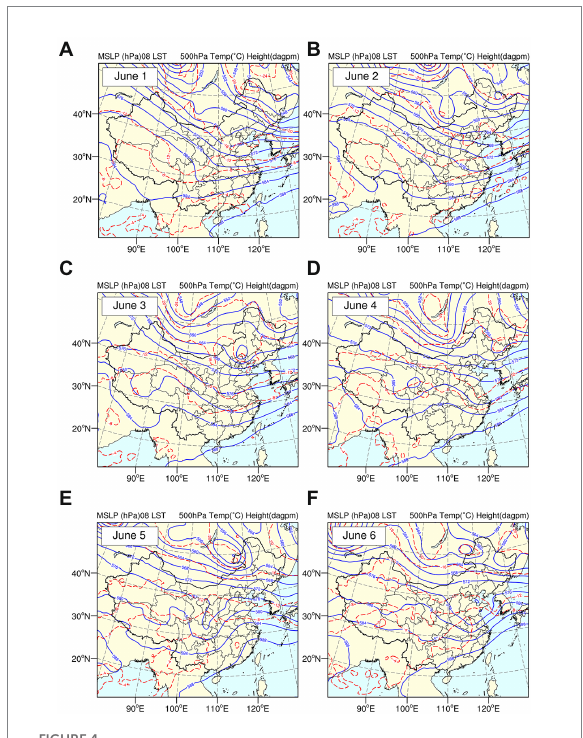
FIGURE 4 (A-F) Map of synoptic pattern at 500 hPa over China from 1 June to 6 June,